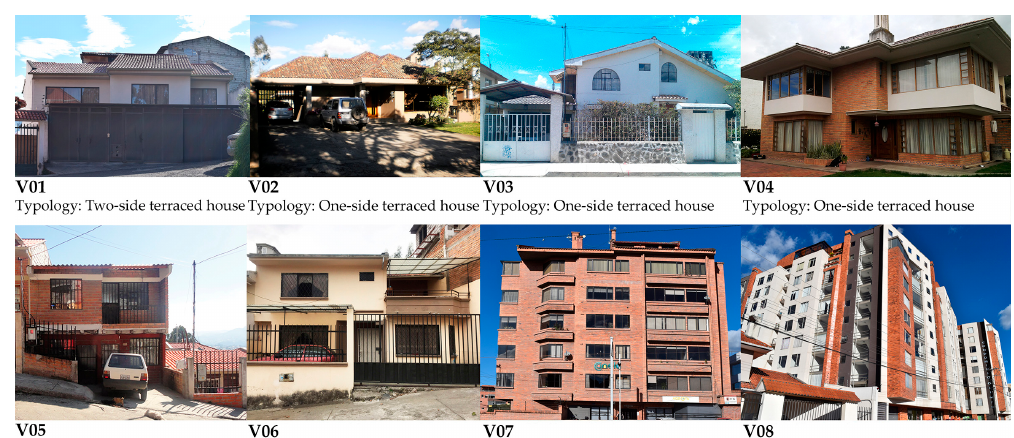
Figure 2. Study Figure 2. Study cases.